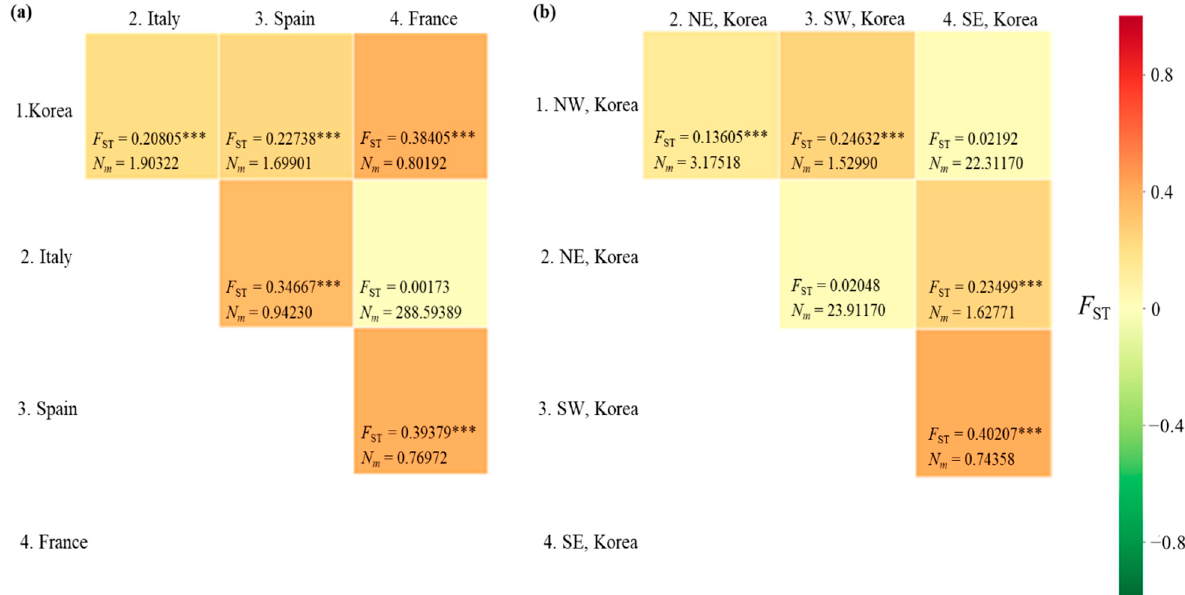
Figure 4. Matrix of pairwise F ST and migration rate ( N m ) between pairs of countries/Korean regions. ( a ) Between countries. ( b ) Between Korean regions. NW, North − West region; NE, North − East region; SW, South − West region; SE, South − East region. *** p < 0.001.